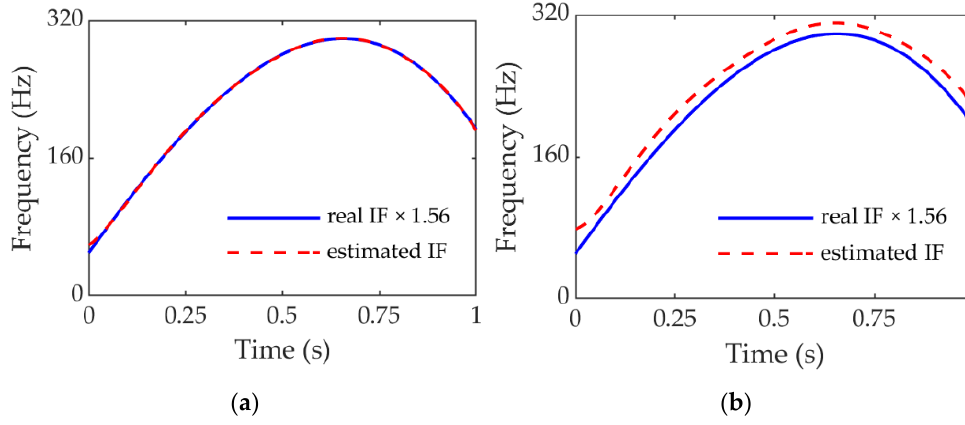
Figure 6. ( a ) The IF estimated by PIFEM for the signal without noise; ( b ) the IF estimated by PIFEM for the signal with noise (SNR = 10 dB).